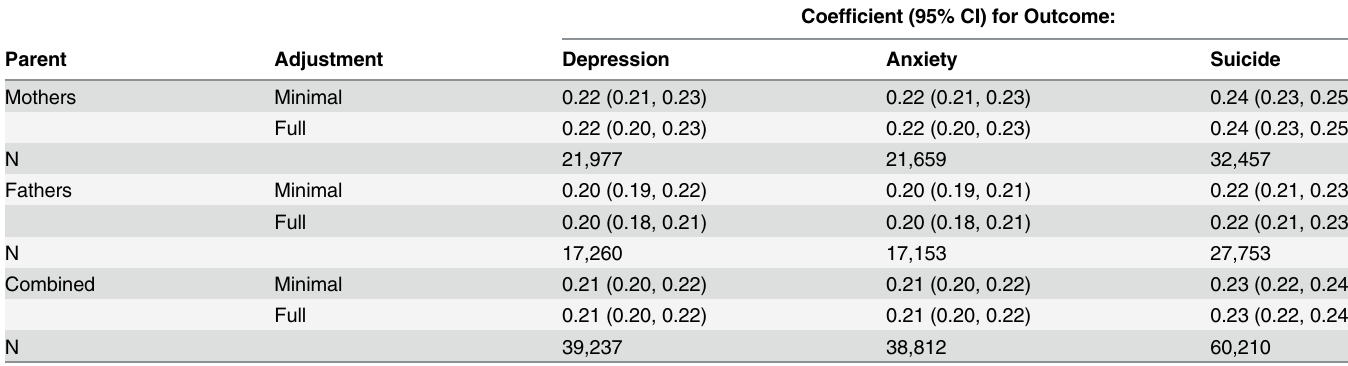
Table 2. Regression coefficients between parental and offspring body mass index within the data set used for each outcome.